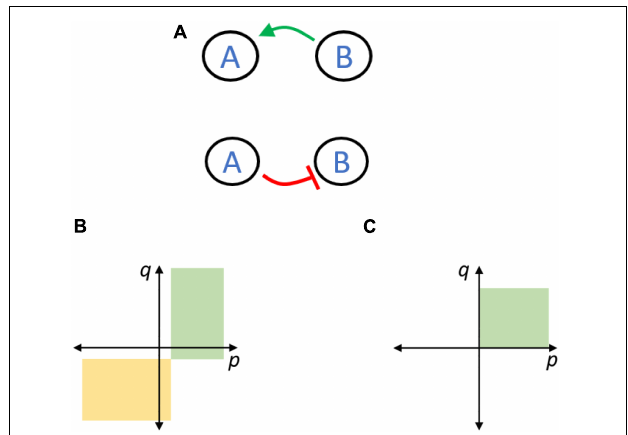
FIGURE 2 | Coexistence in a two-species system can be facilitated via a beneficial ( A top) or an antagonistic ( A bottom) interaction. (B) In the replicator model, coexistence solutions were identified as non-zero solutions of the steady state of the differential equations used. For parameter values in the green and yellow regions, such coexistence solutions were possible. The stability of these solutions was determined by linearizing the equations around these fixed points, and checking the Eigen values of the Jacobian matrix obtained. The coexistence solutions determined by the green region were stable, that is, frequencies of all species were attracted toward this solution. For the yellow region, the coexistence solutions were unstable, that is, frequencies of all species were repelled away from this solution and the fate of the population was extinction of one species. (C) In the Lotka-Volterra model, stable coexistence solutions were determined by numerically solving the differential equations from a random initial condition, and observing if the population approached a point where all species coexisted. For parameter values in the green region, frequencies of both species approached a non-zero value, and hence, the coexistence solution is stable. For other parameter values, frequency of one of the species approached zero. The exact boundaries of the rectangles in panels (B,C) depend on the numerical values of the innate growth rates used in the